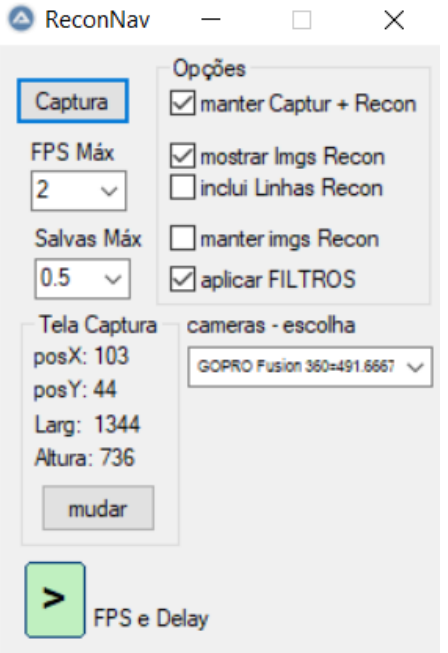
Figure 11. Tool for helping vessels classification. The interface is in